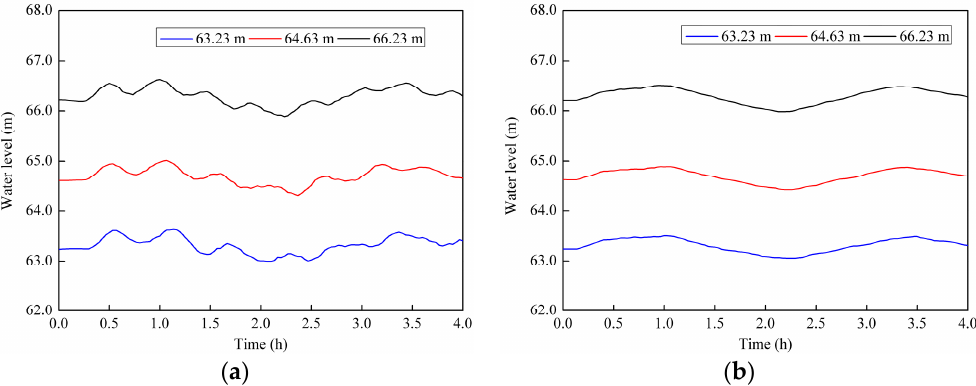
Figure 7. Water level variation process with initial water surface elevation. ( a ) Lower lock head of the ship lift; ( b ) Approach channel.